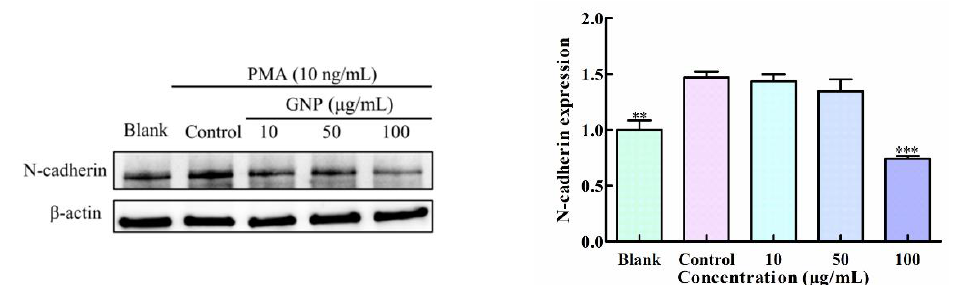
Figure 4. The expression of N-cadherin in HT1080 cells. β -actin was the loading control. HT1080 cells were treated with different concentrations of GNP. Data are shown as mean ± SD ( n = 3). p < 0.05 (*), p < 0.01 (**), p < 0.001 (***) compared with PMA alone treated control group.